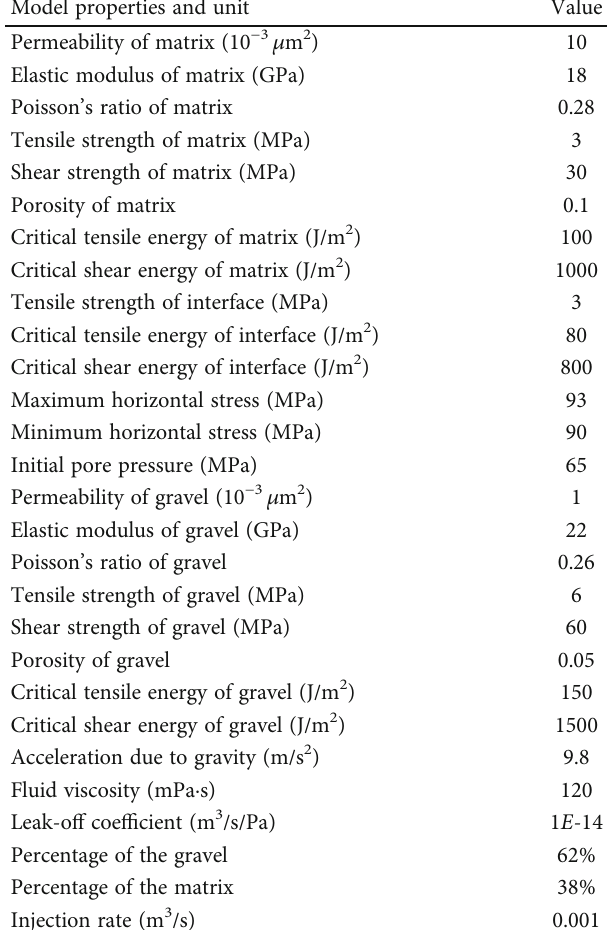
Figure 6: HF propagation after 1s of fracturing and 50 times magni fi cation. Table 2: Input properties in the